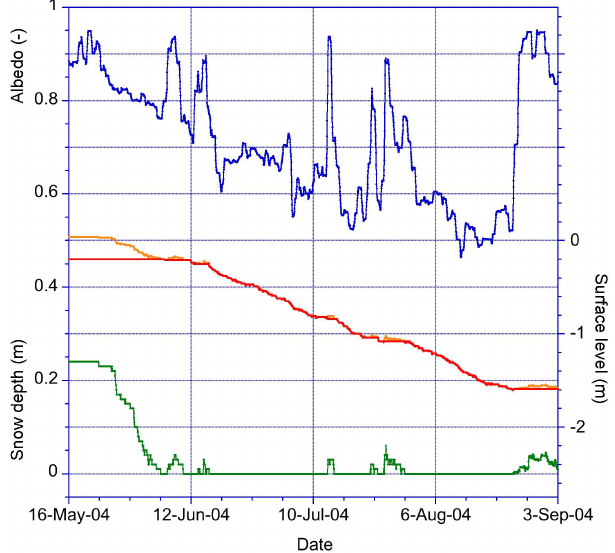
Fig. 2. Albedo (blue line, based on 24-h running mean shortwave fluxes), snow surface (orange line), reconstructed ice horizon (red line) and associated snow depth (green line) derived from sonic height ranger measurements for S6, summer 2004.